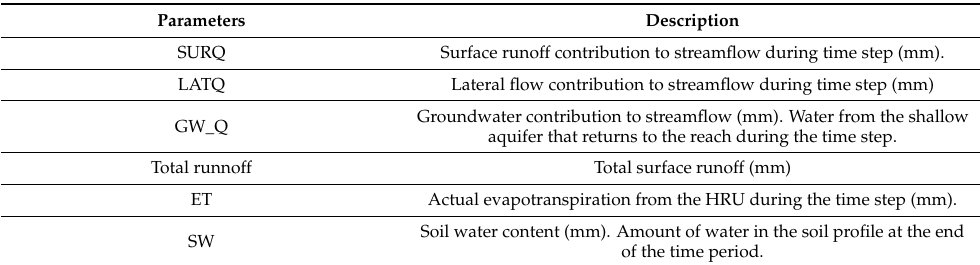
Table 4. Parameters used to evaluate the effect of land use change on the Water Balance of the Paraopeba River